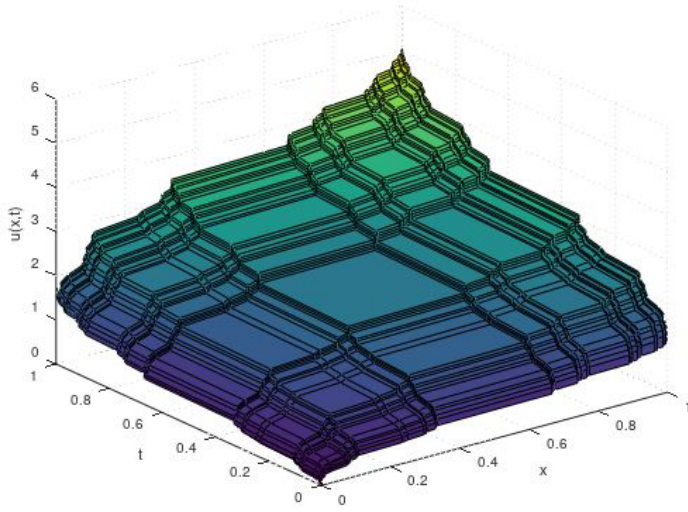
Figure 1. Outcome of Example 1 for α = 0.6309 at n =